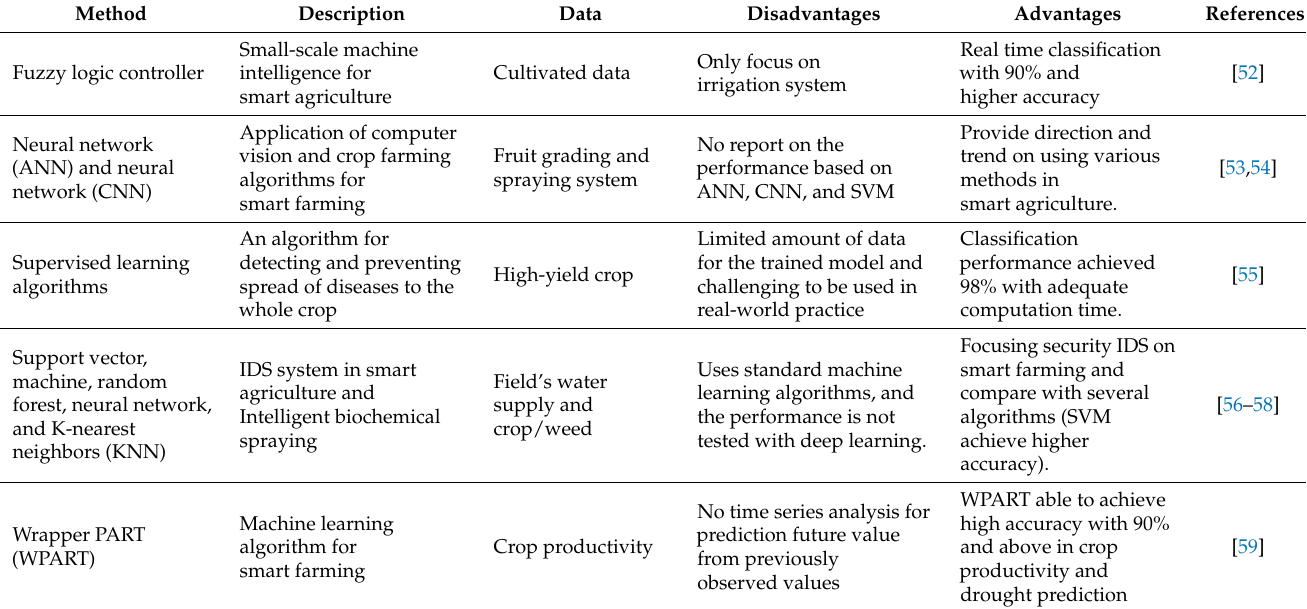
Table 8. Previous reports on traditional machine learning methods in smart